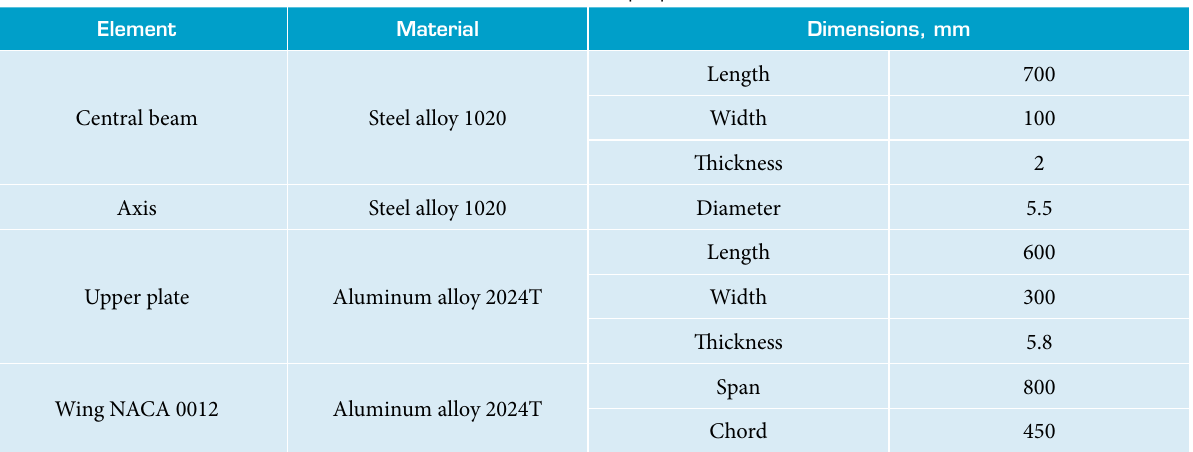
Figure 3. Images presenting the set used on this work. Table 1. Structure